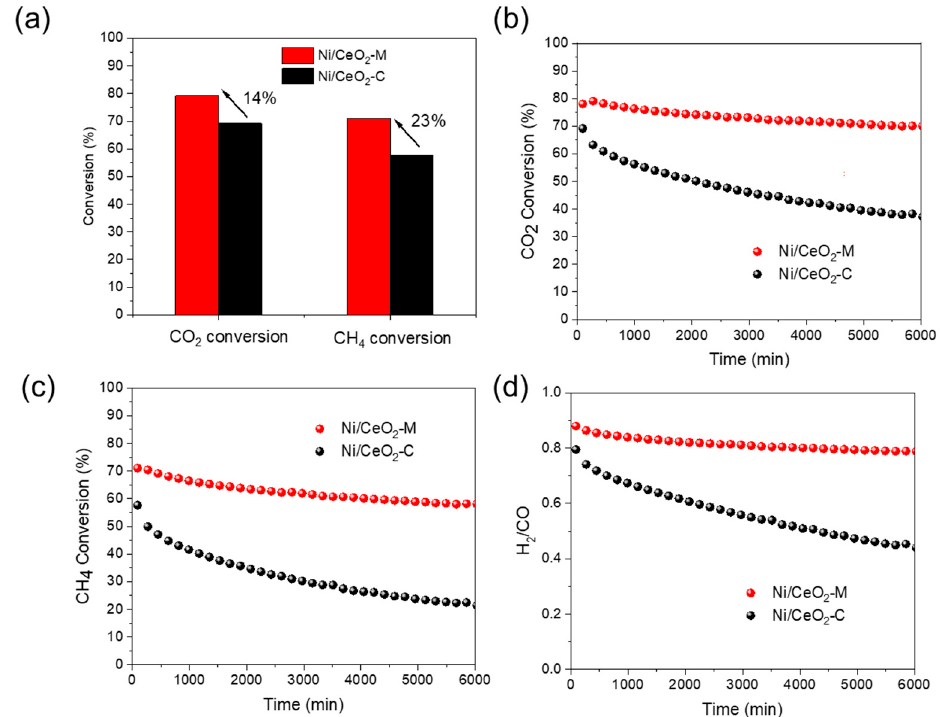
Figure 4. ( a ) Catalytic performance comparation; ( b ) CO 2 conversion during 50 h, ( c ) CH 4 conversion during 50 h, and ( d ) H 2 /CO ratio during 50 h of Ni/CeO 2 -C and Ni/CeO 2 -M catalysts.